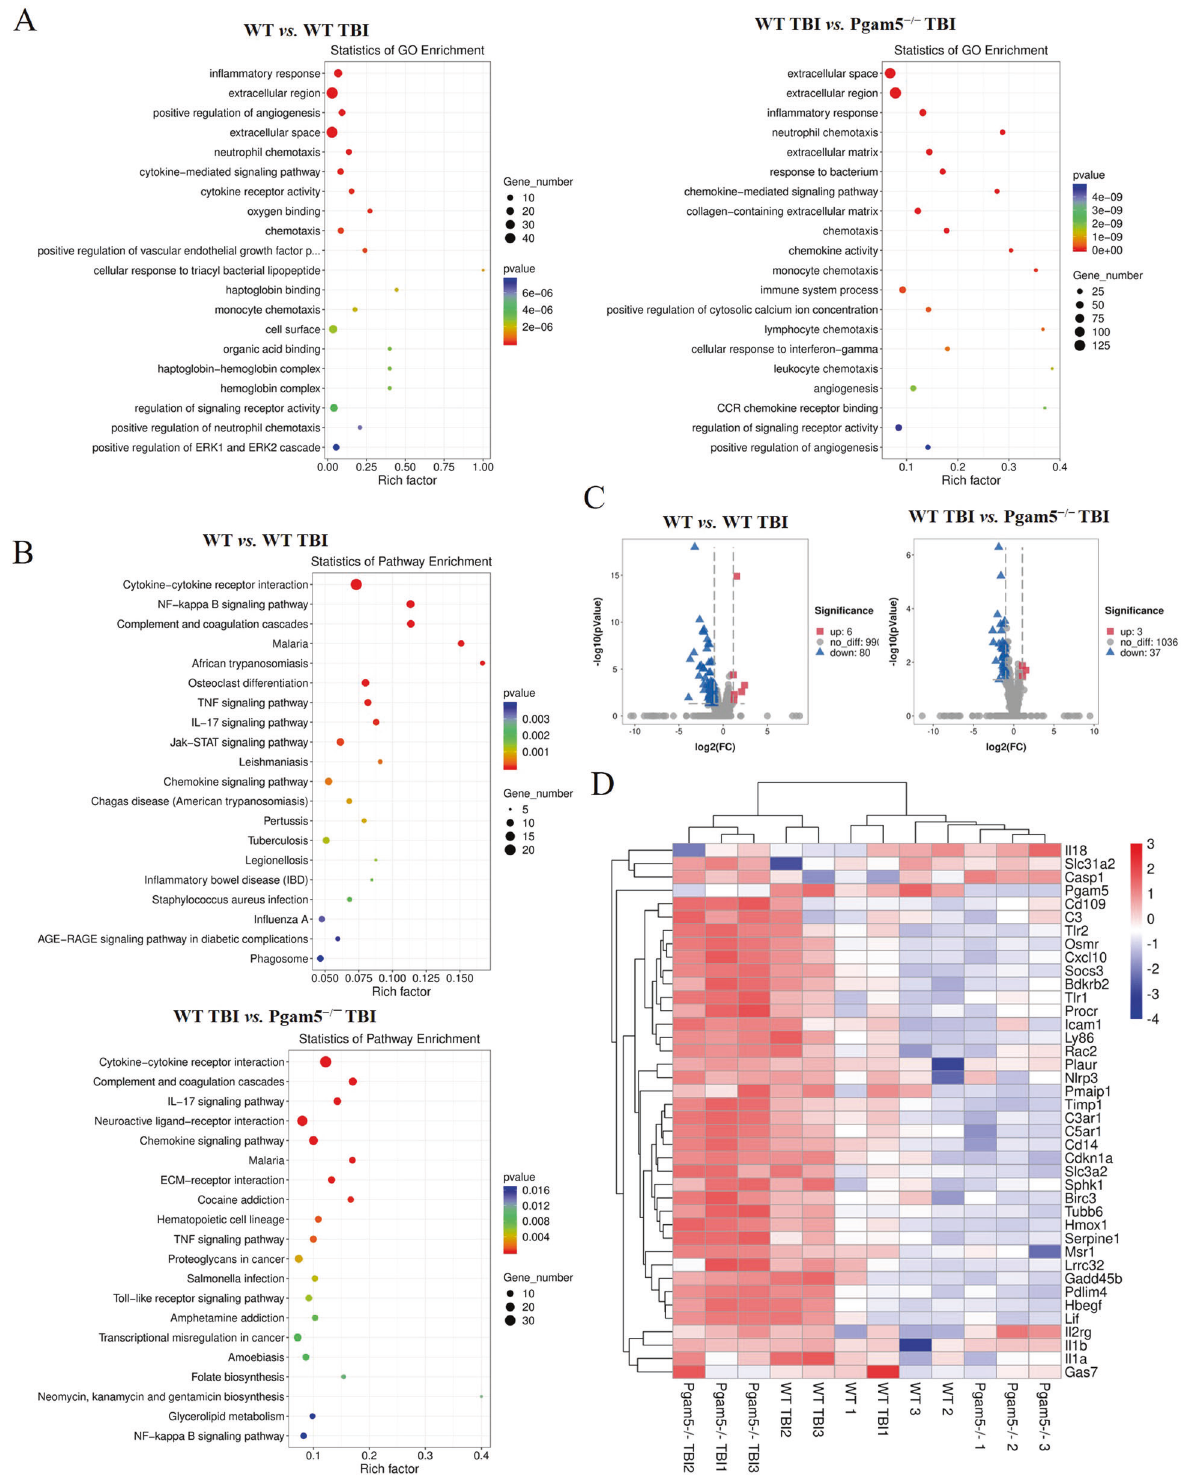
Fig. 2 RNA-seq analysis of cortical tissue. Total 55,450 genes of cortical tissues were detected by LC Sciences for RNA-seq analysis. A GO enrichment analysis was carried out to classify the biological function of DEGs. Each box shows the GO term number, the p-value, and GO term. B KEGG pathway enrichment analysis for DEGs. The top 20 KEGG pathways are shown. The box color indicates the level of statistical signi fi cance. The dot size means the gene number. C A 1076 genes associated with in fl ammatory response were isolated and analyzed by VolcanoPlot. D Heatmap analysis of in fl ammation-related DEGs between WT group, WT TBI group, Pgam5 − / − group, and Pgam5 − / − TBI group. Only the top 40 genes were included in the DEGs heatmap.